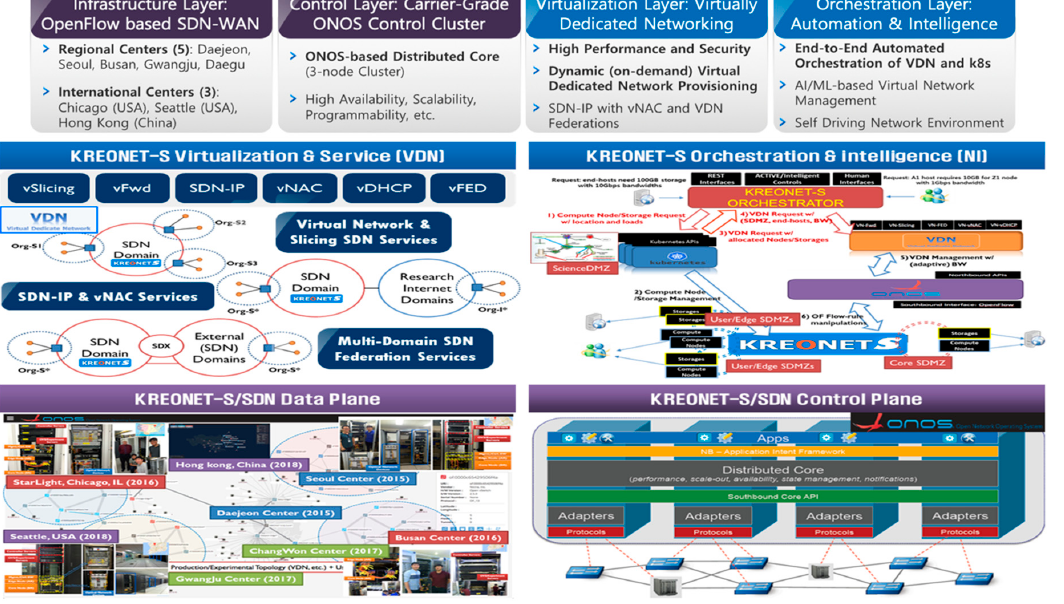
Figure 2. Layered architecture and development status of KREONET-S.